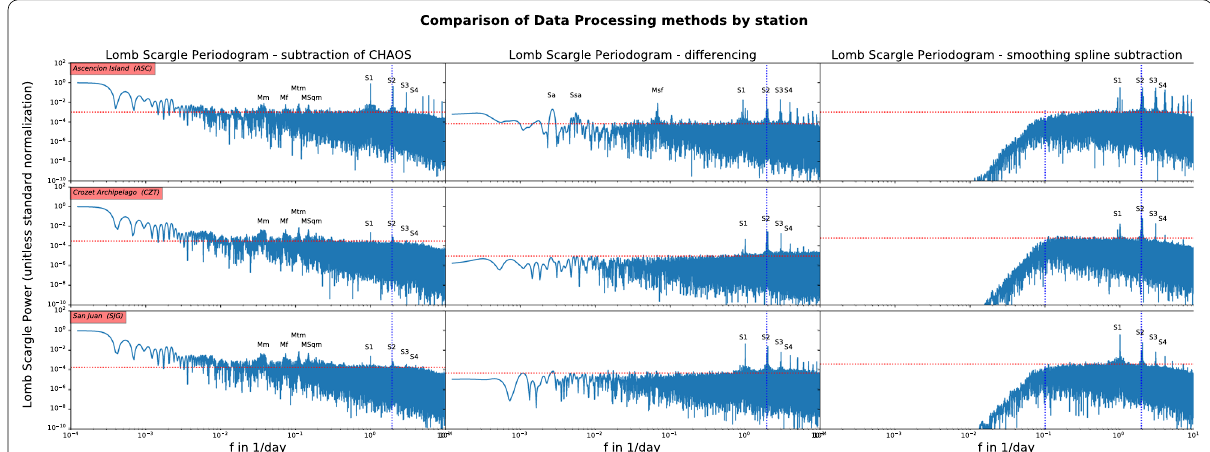
Fig. 1 Lomb–Scargle Periodograms of the residual time series data at all three analyzed Intermagnet stations ASC (top row), CZT (middle row) and SJG (bottom row)). In each column a different removal technique was applied: the subtraction of the model prediction of the CHAOS model (left), differencing of subsequent data points (middle) and the substraction of a smoothing spline (right). Dotted red lines indicate an estimation of the noise level. The dotted blue lines visualize the frequency of the prinicipal lunare tide M2. Other prominent frequency peaks or well‑known tidal frequencies are marked with their tidal code, e.g., Sa, Ssa or Mf. The halved dotted blue lines in the right column indicate the targeted cutoff frequency for the smoothing spline ( 10 − 1 d − 1 ). The amplitudes, noise level and distribution of significant peaks vary as expected with the location due to differing coastal, oceanic and geographical conditions. However, the distribution of detected periodic signals and their signal strength varies with the chosen processing method. Histograms of the residual data obtained from the presented data processing after subtracting smoothing splines are included in the Additional file 1: Figures